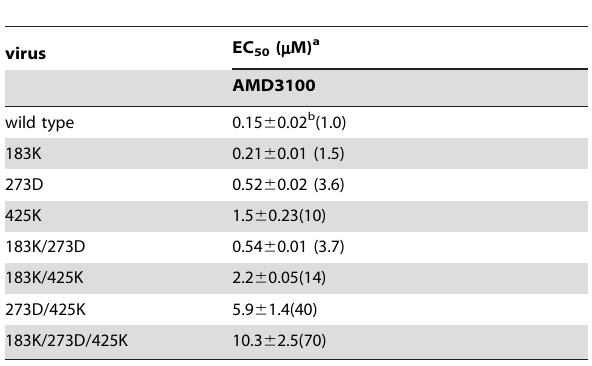
Table 2. Susceptibilities of recombinant pseudotyped viruses to CXCR4 inhibitors determined by single-round entry